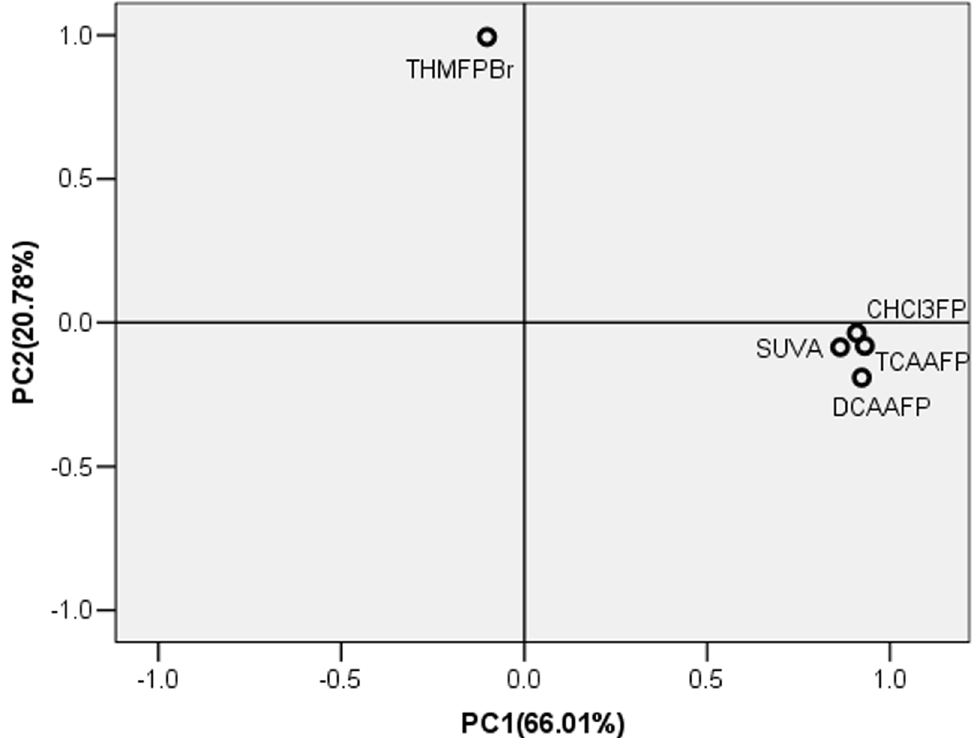
Fig 3. Property — property plots of PCA factor loadings between four individual DBPsFP and SUVA index.